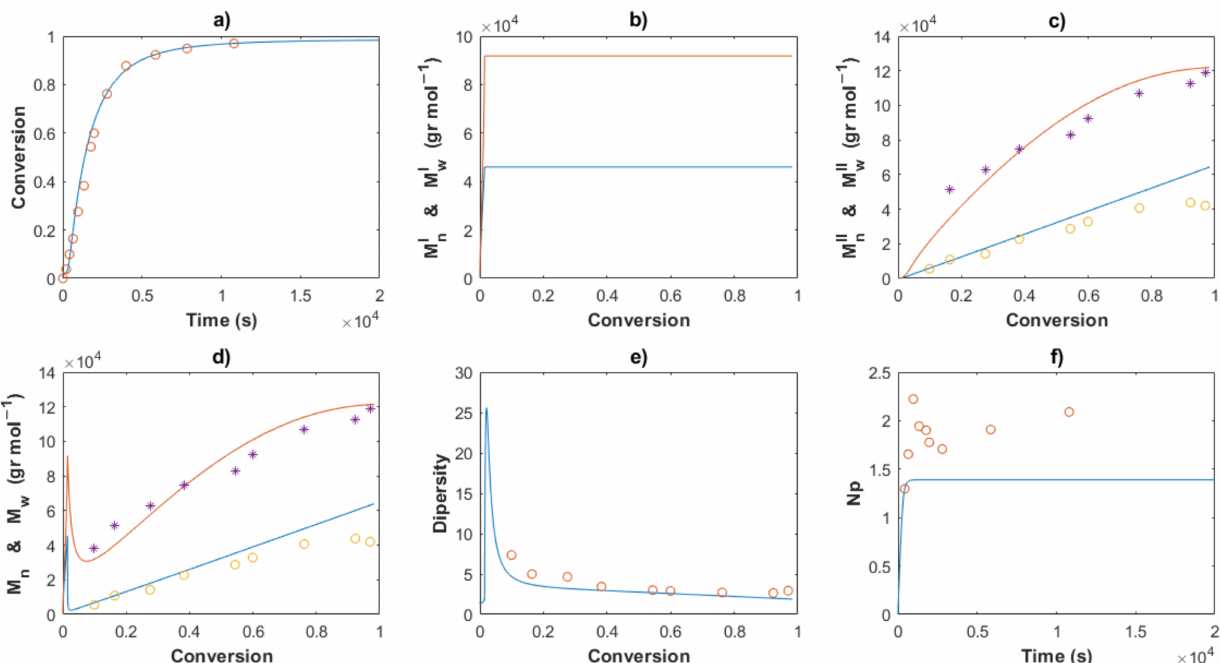
Figure 12. Comparison between the experimental data (symbols) and the model solutions (lines) for Exp 3: ( a ) Conversion profiles, ( b ) M nI and M wI versus conversion, ( c ) M nII and M wII versus conversion, ( d ) M n and M w versus conversion, ( e ) Dispersity, ( f ) Np versus